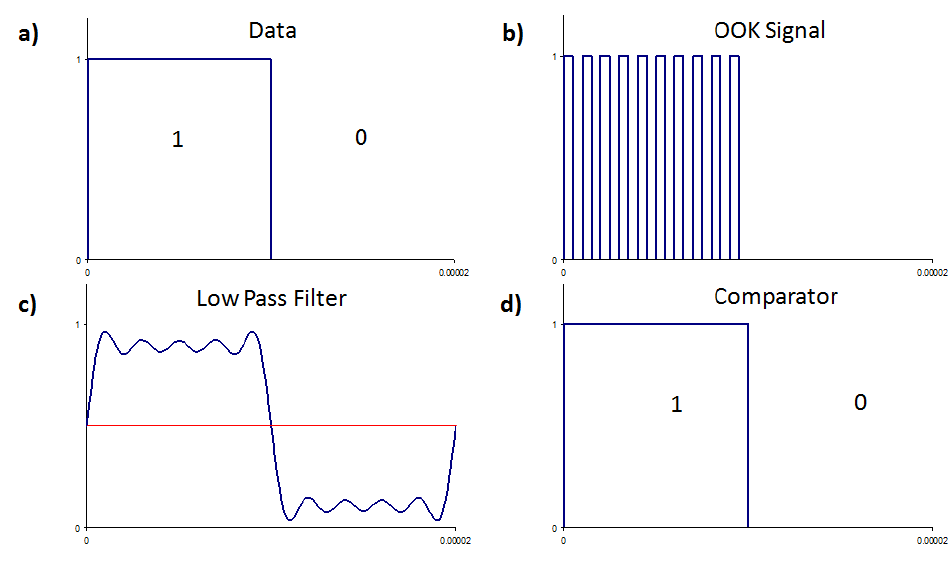
Figure 2. Decoding an amplitude shift keying signal, (a) the digital data to be transmitted, (b) the on-off keying signal, (c) the rectified and low pass filtered signal, (d) digital information recovered after a